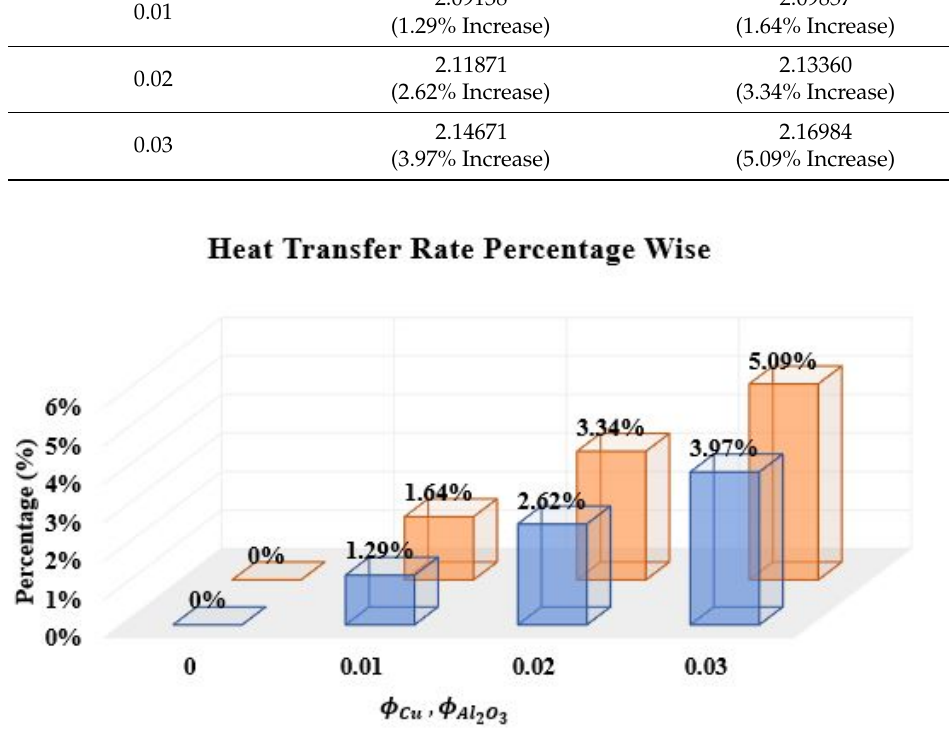
Figure 8. Versus